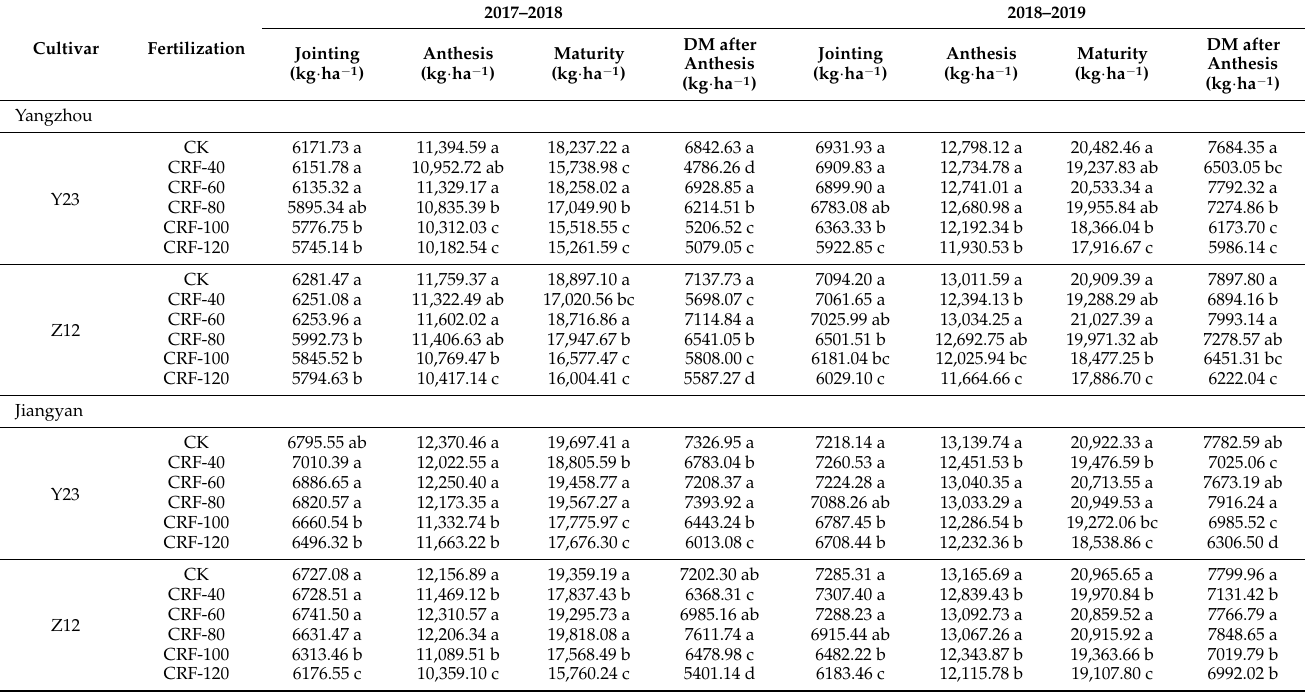
Table 3. Biomass accumulation of wheat shoot in different CRF treatments in Yangzhou and Jiangyan